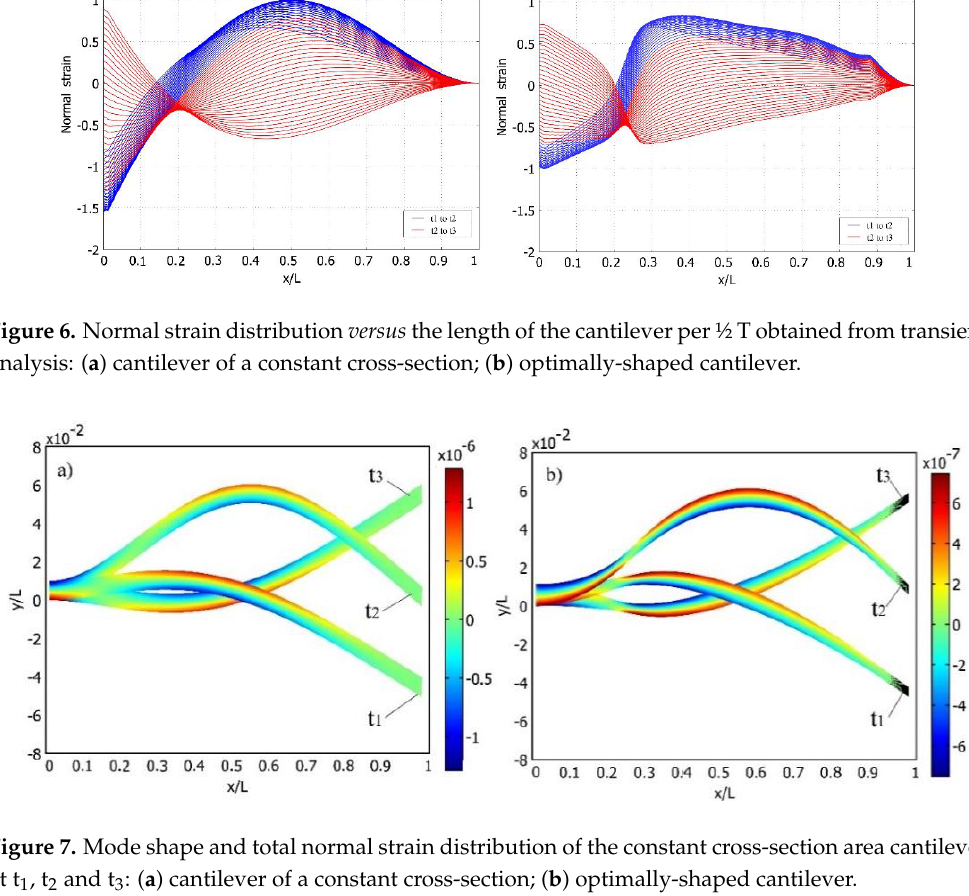
Figure 5. Cantilever free end displacement in the transverse direction: ( a ) dynamical process; ( b ) region of steady-state vibrations; ( c ) ½ T period of vibration for the analysis of the position of the cantilever strain nodal point. The first quarter of period ( t 1 , t 2 ) is colored in blue and the second ( t 2 , t 3 ) in red for the clarity of the transition processes taking place in the face of the cantilever during the vibration. The same coloring scheme is used in Figure 6, where the normal strain distribution along the upper face of both cantilever setups is shown per ½ T of the cantilevers’ transverse vibration. The number of curves in Figure 6 represent the number of interpolated time step values ∆𝑡 𝑖 between t 1 and t 3 . Figures 6 and 7 clearly reveal that, overall, normal strain output amplitudes are higher in the